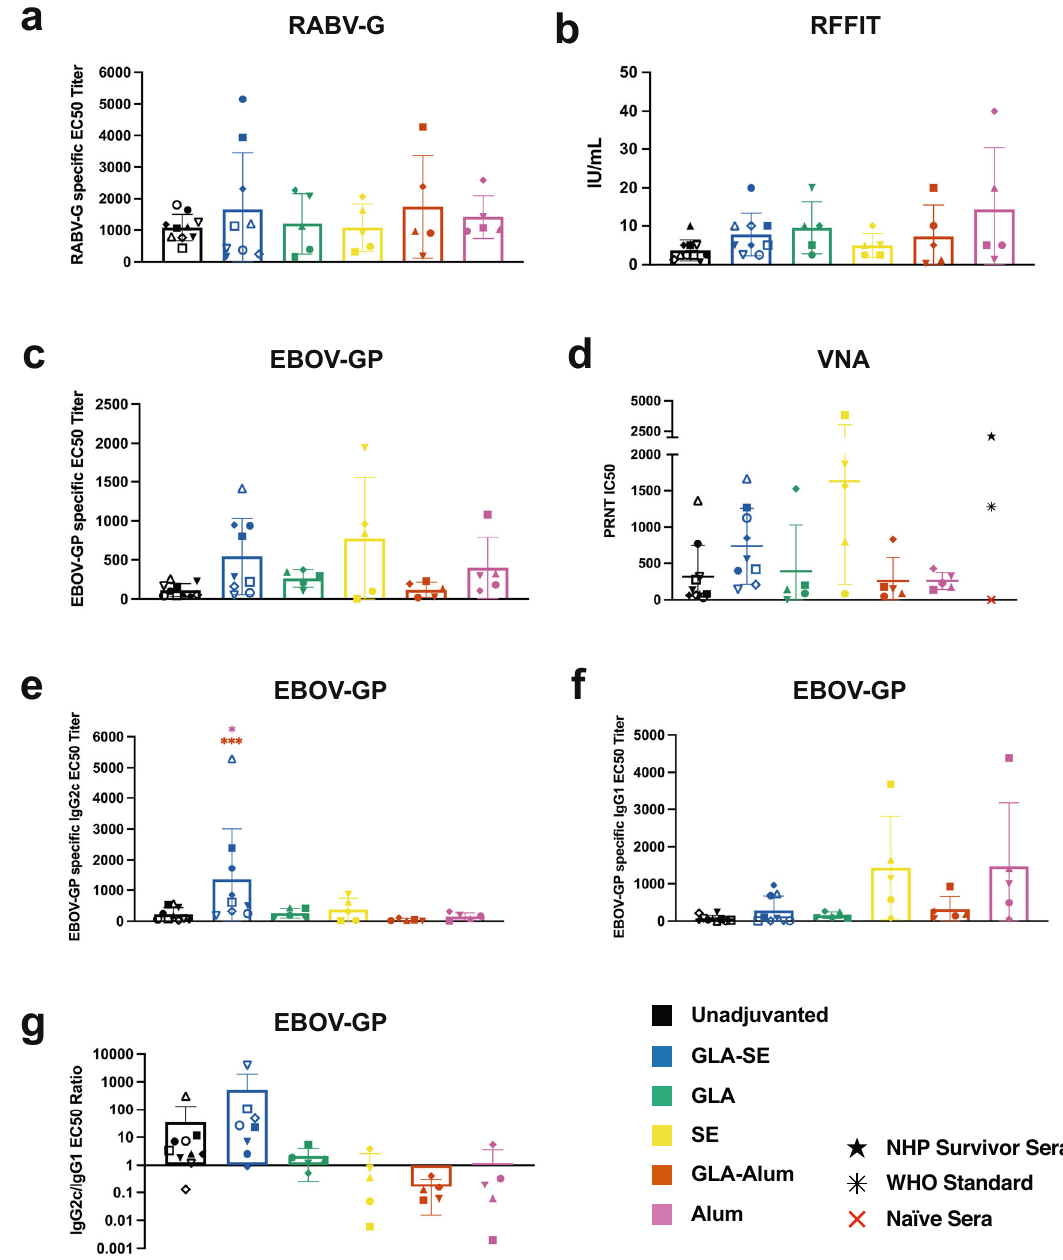
Fig. 6 FILORAB1 provides long-term antibody titers 1-year post immunization. a RABV-G speci fi c antibody ELISA of sera from C57BL/6 mice immunized with a prime-boost schedule at day 0 and week 4 with FILORAB1 unadjuvanted or with GLA-SE, SE, GLA-alum, or alum at 1 year- post immunization. Data reported as average half-maximal effective concentration (EC50) titer (bars) determined from individual mouse serum (symbols) ELISA curves. b RABV-neutralizing antibody titers by RFFIT reported in international units (IU) per mL of average neutralizing titers (bars) of individual mouse serum (symbols). c EBOV-GP speci fi c antibody ELISA at 1 year. d Neutralizing antibody titers at 1 year reported as half-maximal inhibitory concentration (IC50) of serum dilution. NHP survivor sera (black star) is pooled from a previous EBOV challenge experiment. The WHO standard (black asterisk) consists of convalescent plasma pool. e EBOV-GP speci fi c IgG2c, f IgG1, and g ratio of IgG2c/ IgG1 ELISA at 1 year. Error bars represent SD from the mean. Statistics are by one-way ANOVA with post hoc Tukey ’ s test of log-transformed EC50, IU, or IC50 titers. p > 0.1234 (ns), p < 0.0332 (*), p < 0.0021 (**), p < 0.0002 (***), p < 0.0001